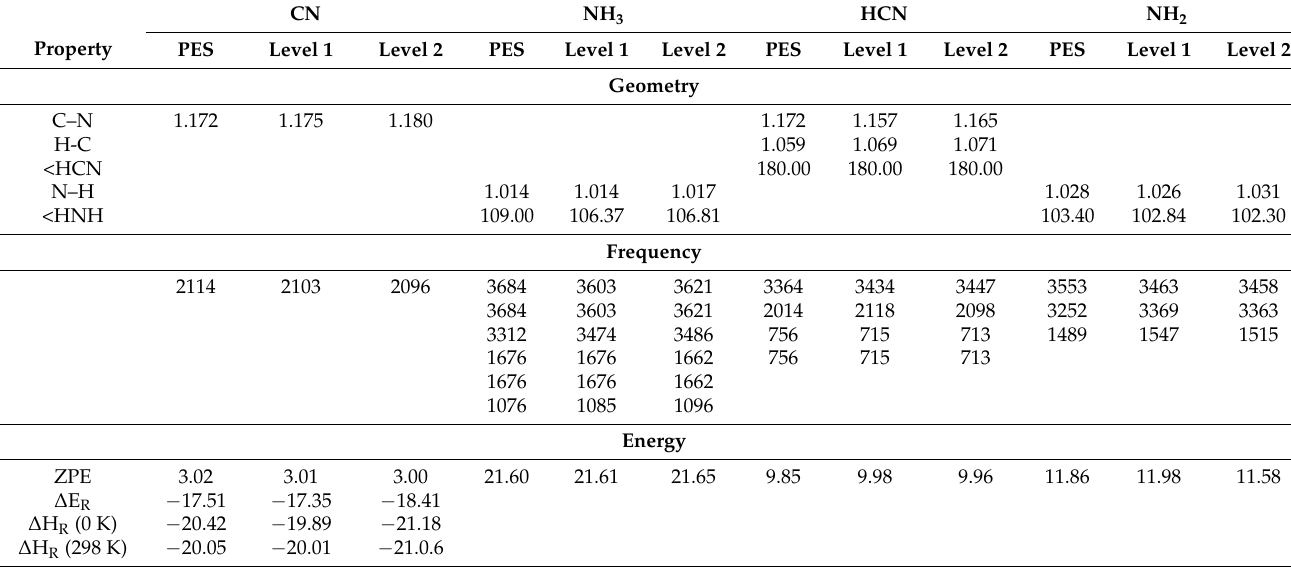
Figure 1. Classical energy diagram of the stationary points for the CN + NH 3 reaction. First entry, Level 1, CCSD(T)-F12a/aug-cc-pVDZ; second entry, Level 2, CCSD(T)/6-311++G(d,p); and third entry, potential energy surface (PES)-2020. As insets, we include the optimized geometries of the reactant complex, RC2, saddle point and product complex. Energy in kcal mol − 1 and distances in Å. Blue ball: N atom; gray ball: H atom; black ball: C atom. Table 1. Properties of reactants and products (distances in Å, frequencies in cm − 1 , energy in kcal mol − 1 ) with PES-2020 and ab initio calculations a